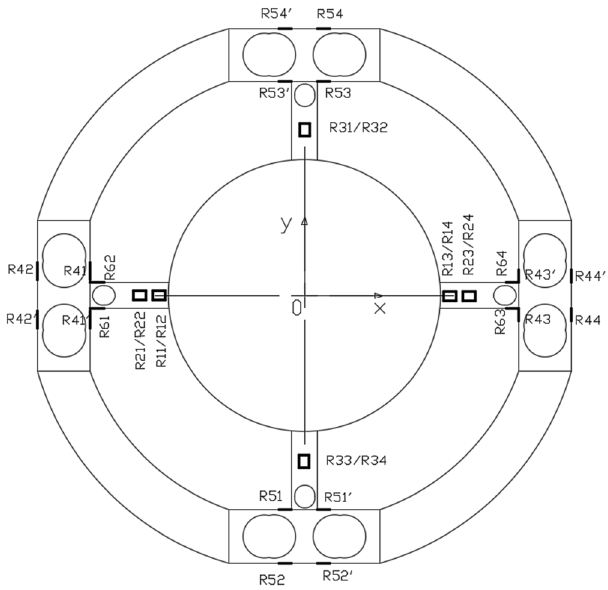
Figure 13. The strain gauges position of the novel six-axis force sensor. Figure 13. the strain gauges position of the novel six-axis force sensor. Table 3. Plus or minus of strain under forces or